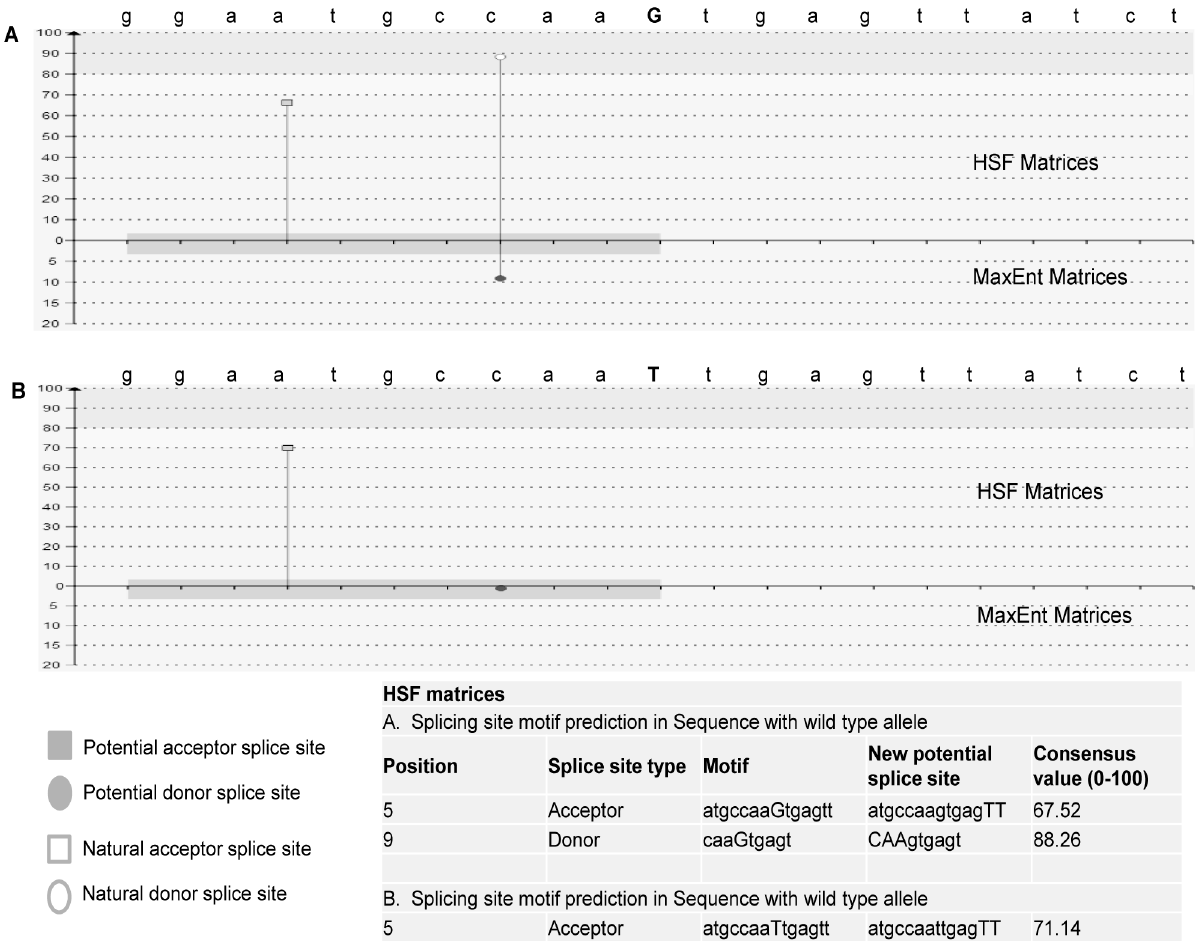
Figure 4. Bioinformatics prediction of splicing site motif (donor/acceptor). Twenty one base pair sequence flanking of mutation site with wild type ( A ) and mutant allele ( B ) was tested for prediction of splicing site motif (donor or acceptor).